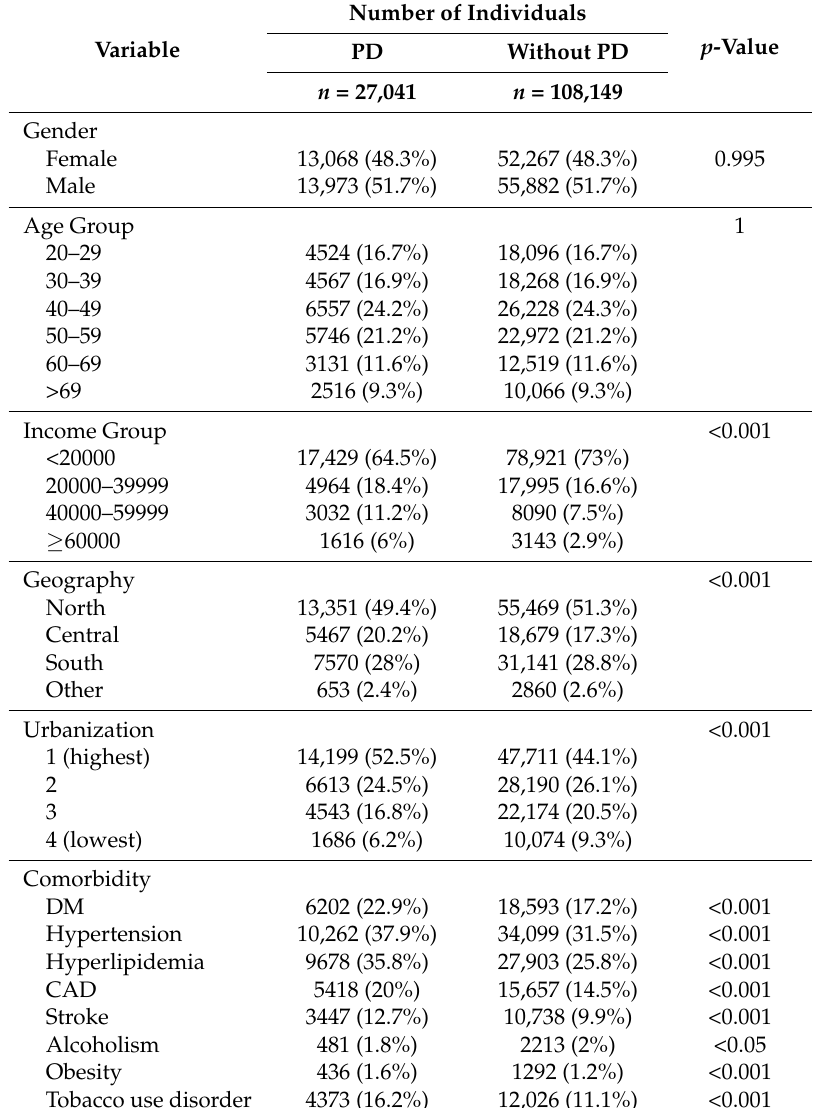
Table 1. Distribution of gender, age group and comorbidity in individuals with and without